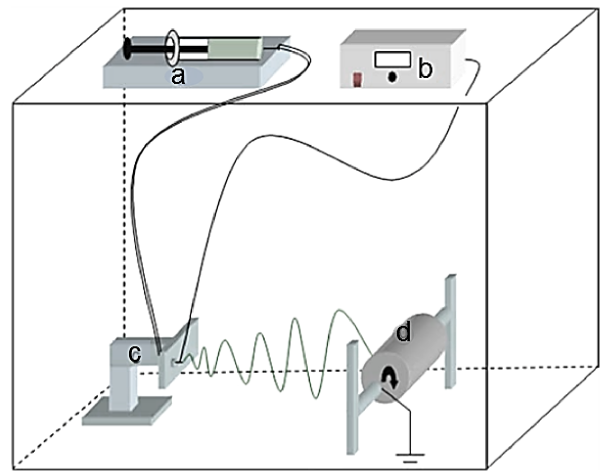
Figure 1. A diagram of the custom-built electrospinning setup: (a) syringe pump, (b) high voltage supply, (c) transition stage, and (d) rotating